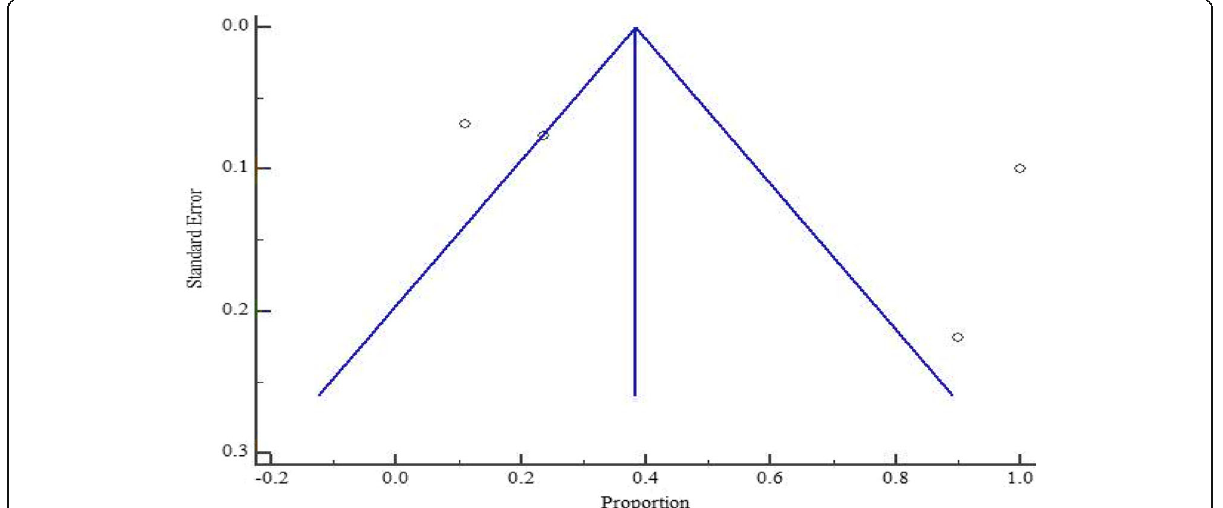
Fig. 9 Bias assessment plot of studies that reported bacterial contamination in herbal medicines sold in Uganda from the year 2000 to 2020